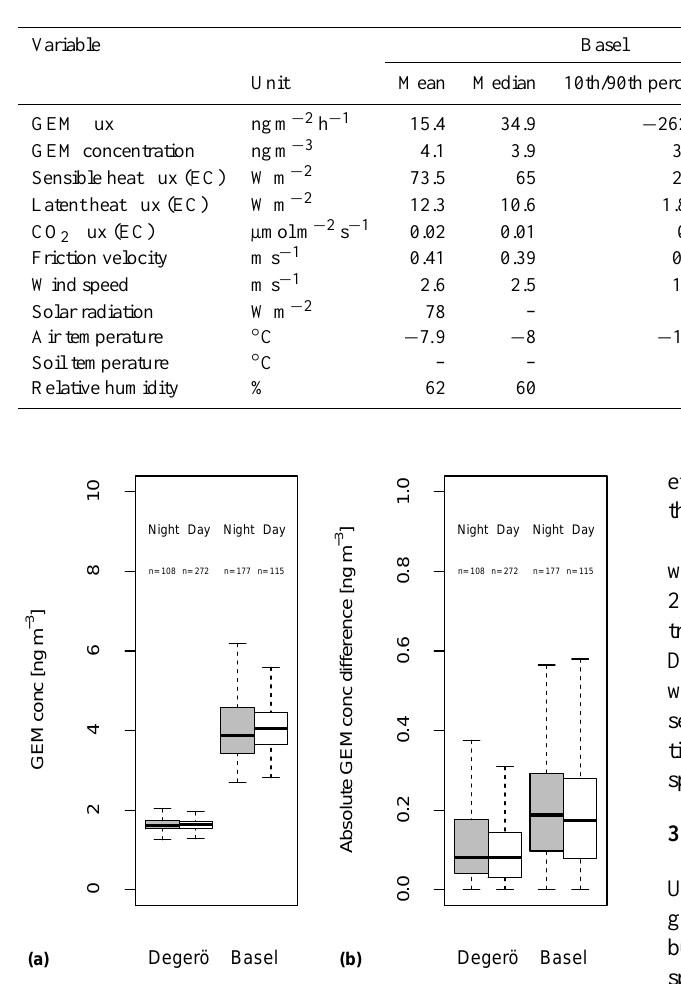
Table 2. Summary of averaged, median and distribution of GEM fluxes, atmospheric GEM concentrations and environmental conditions during the measurement campaigns. Pearson correlation coefficients ( r ) between GEM flux and environmental parameters are given when statistically significant ( p< 0 . 05).